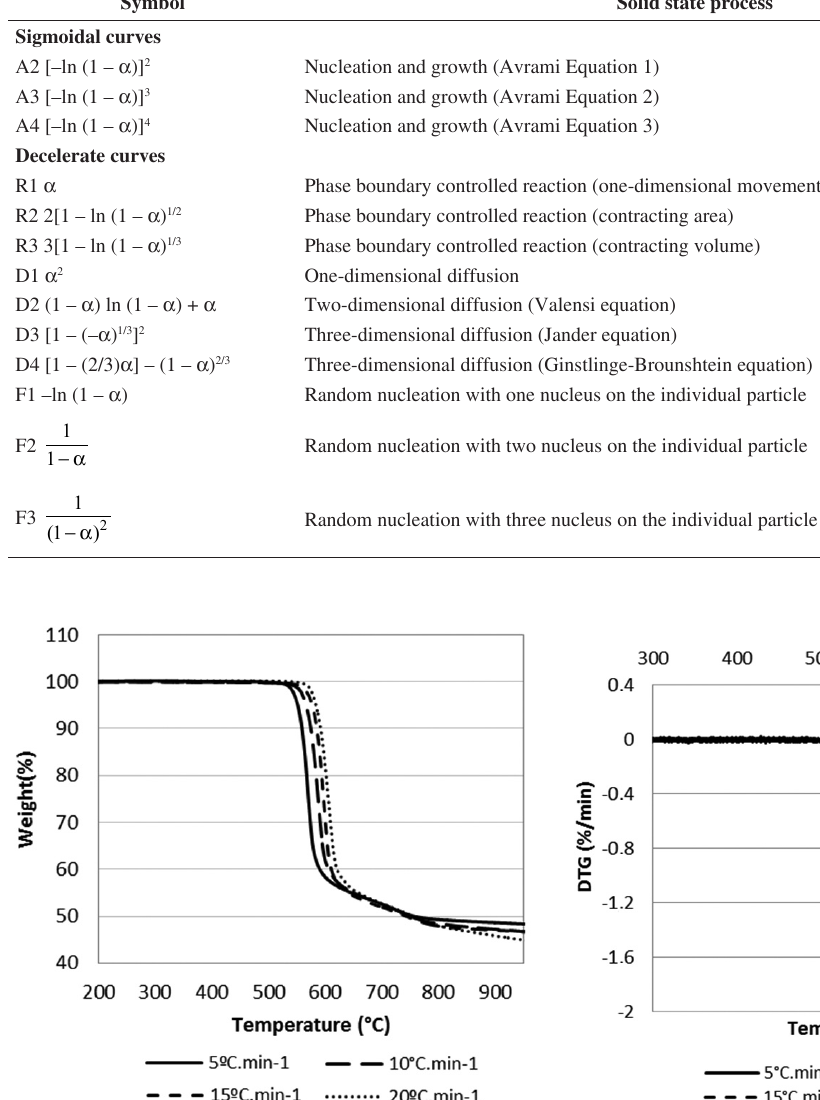
Table 1. Algebraic expressions for g(x) for the most common solid state mechanisms 23 . Symbol